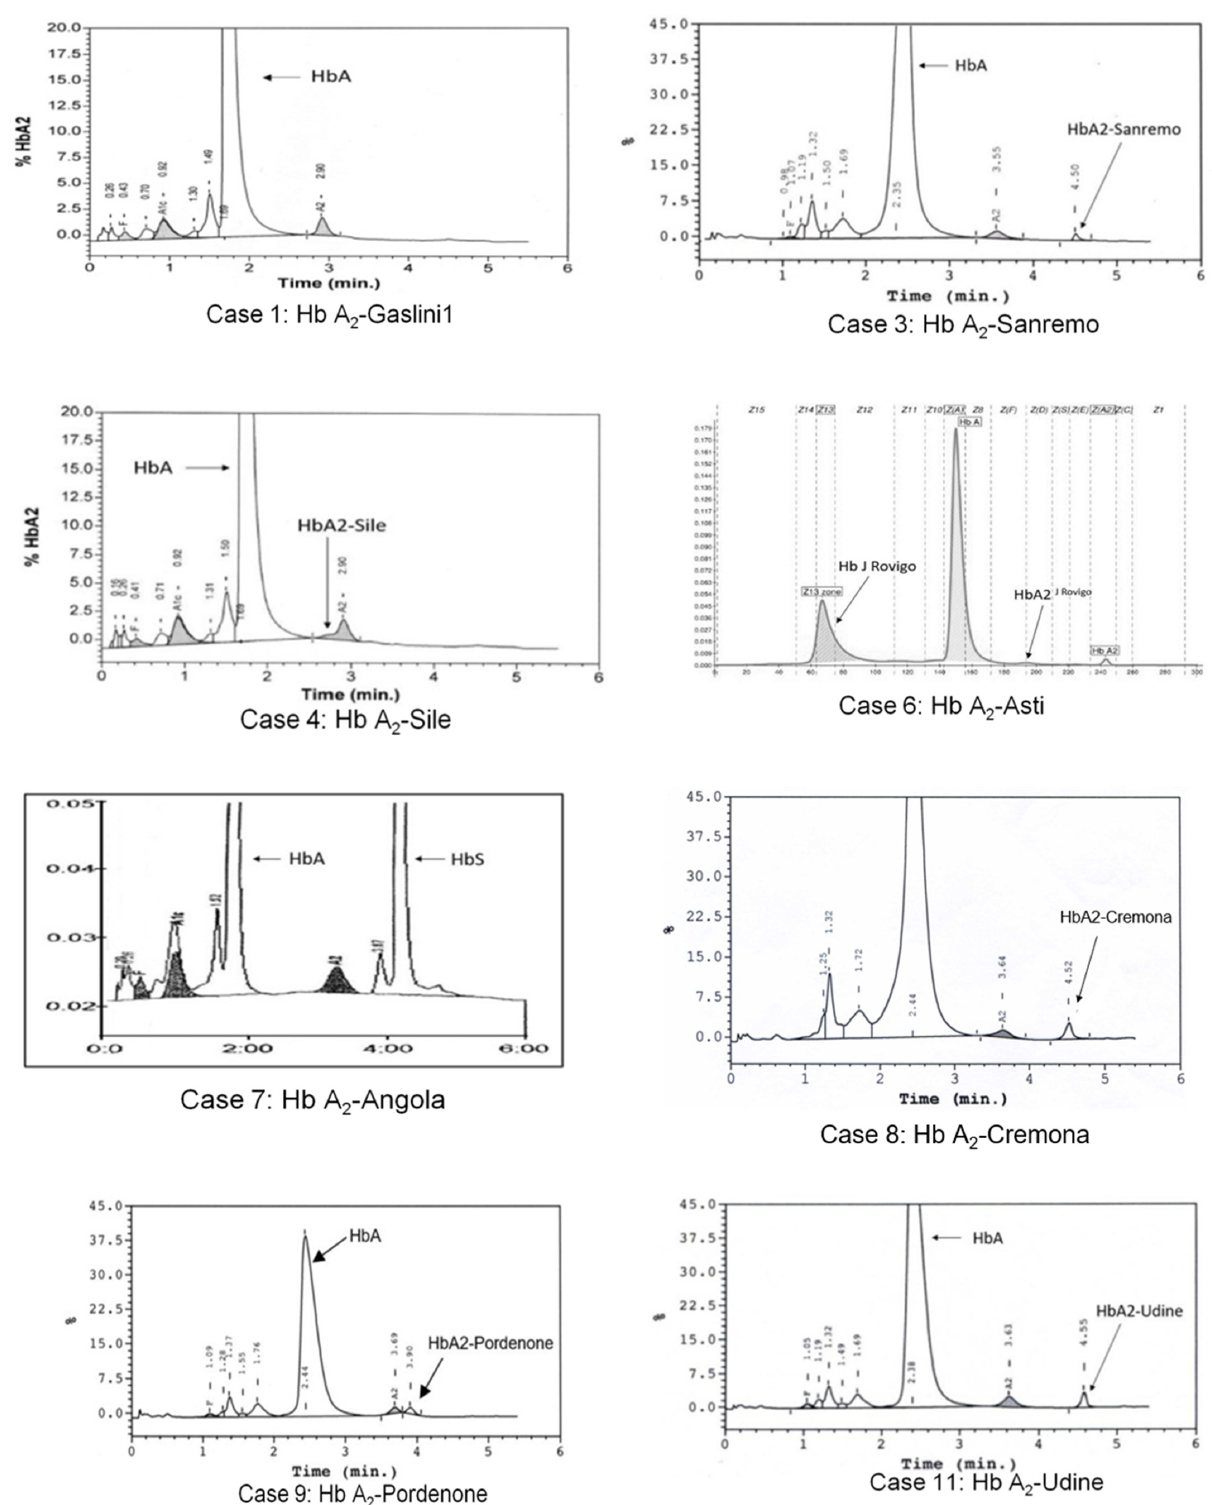
Figure 1. HPLC and CE profiles present in the eight subjects with Hb A 2 variants: case numbering corresponds to that shown in Table 1. Case 6 shows the profile in which the Hb A 2 -Asti or ( α 2 δ 2 Asti ) is not visible as co-migrating with Hb A. Instead, we can observe Hb A 2 J-Rovigo or ( α 2 J-Rovigo δ 2 ) is not quantifiable, but visible as a basic movement in the “Hb F zone” and produced by the presence of α J-Rovigo chains that, with the normal delta chains, form a mutated tetramer. No Hb A 2 variant can be observed for cases 1 and